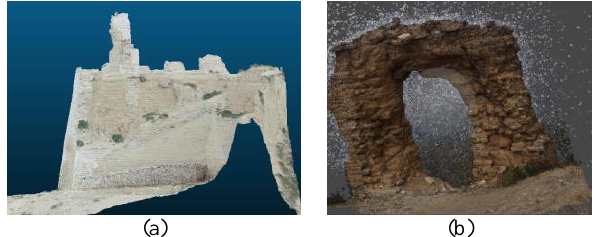
Figure 9. The generated DIM points of moon gate; (a) after collapse; (b) before collapse (2) The reconstructed “Moon Gate” From the recovered point cloud data, the north-south and east- west span of the base of “Moon Gate” was 14.77m and 8.26m separately. The thickness of each earth layer was about 10cm and the size of the existing brick around was 38 x 20 x 8cm to 40 x 26 x 10cm. The top of “Moon Gate” was consist of square green brick and the size was 32cm x 32cm x 8cm. The rest were the broken bricks. Due that the shape and scale of these broken bricks were different, these broken bricks were difficult to be calculated systematically.